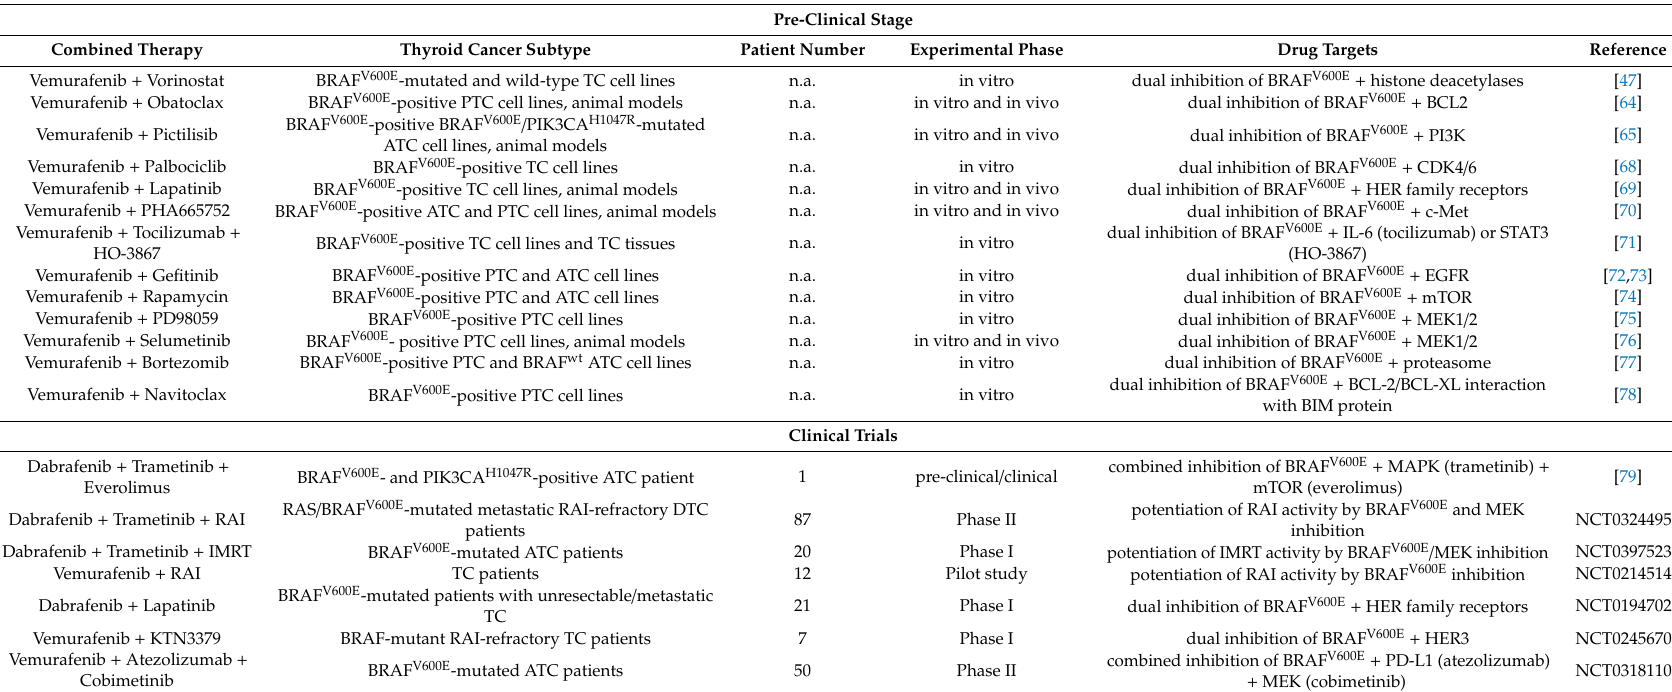
Table 1. Novel therapeutic strategies based on the combination of BRAF inhibitors with other targeted agents under pre-clinical and clinical development in thyroid